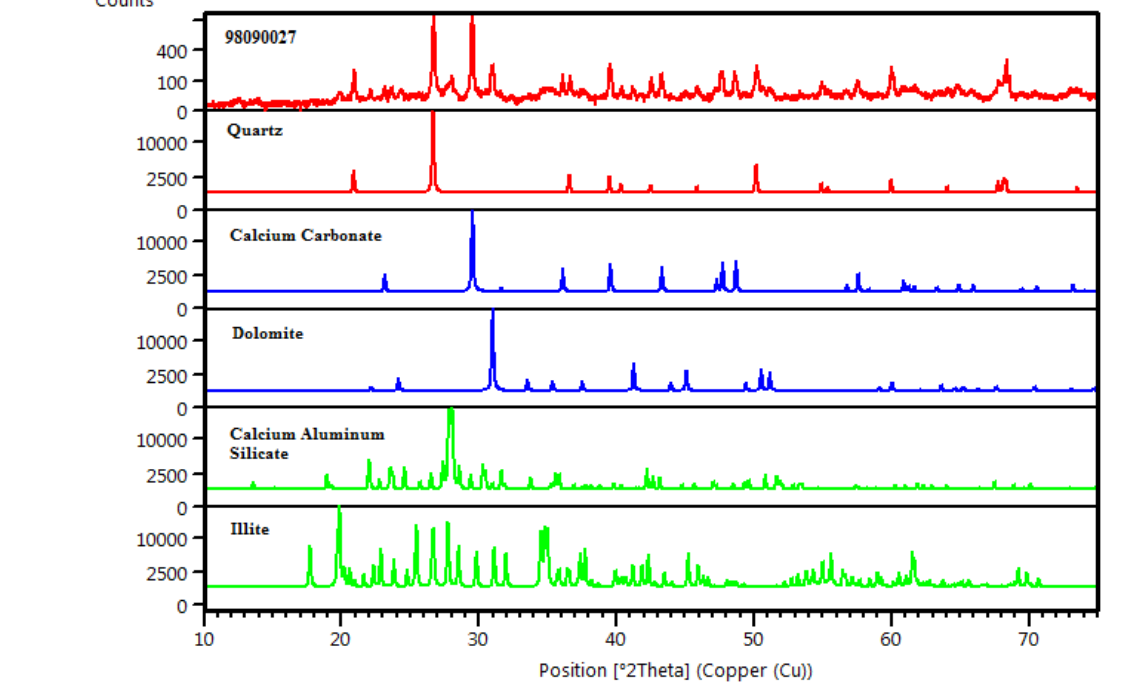
Fig. 8. Figure 8. XRD pattern of the soil sample collected from 12m depth of study area XRD pattern of the soil sample collected from 12m depth of study area